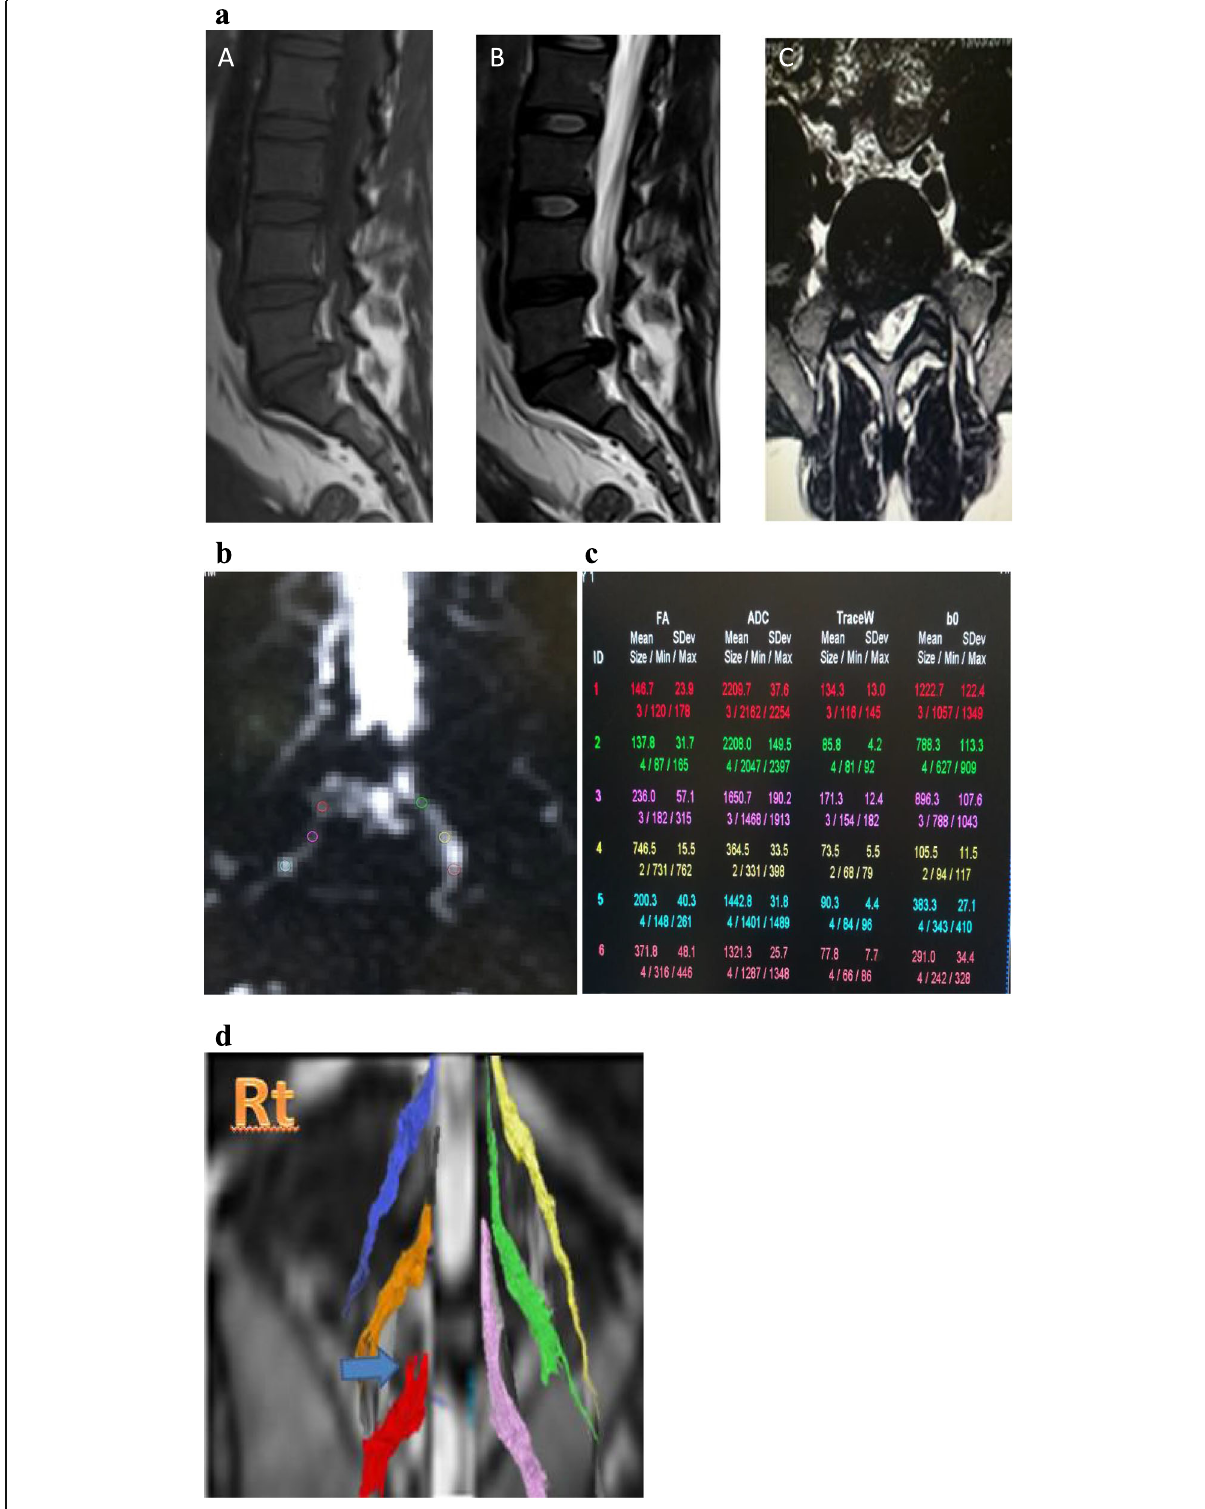
Fig. 6 a Thirty-five-year-old male patient, MRI sagittal T1 (A), sagittal T2 (B), and axial T2 (C) images show L5/S1 right posterolateral disc extrusion. b , c DTI of the same patient with FA and ADC values measured along right and left S1 nerves using ROI revealed mean FA of right nerve 0.194 and of left nerve 0.418. Mean ADC of right nerve 1767 and of left nerve 1297. d Tractography image of the same patient revealed distortion of right S1 nerve